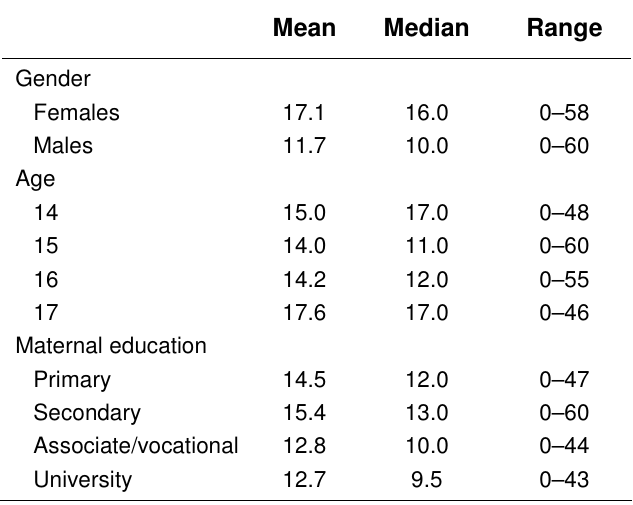
BDI-II Mean Scores by Key Demographic